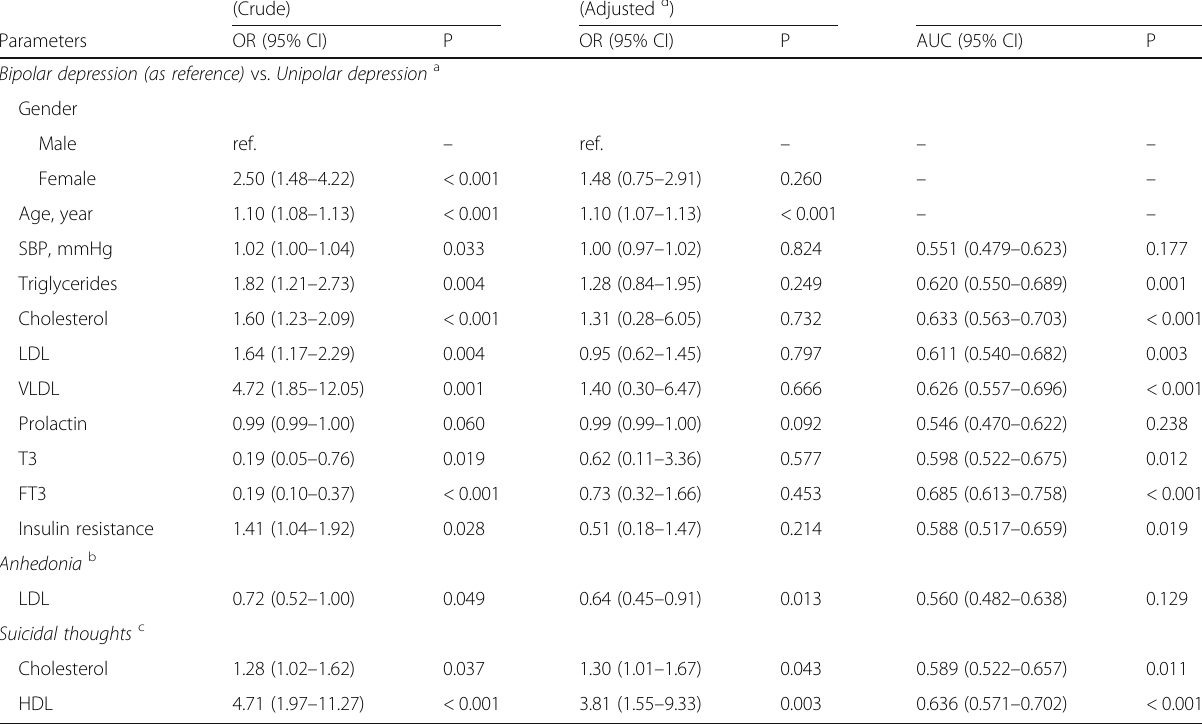
Logistic regression (Adjusted d